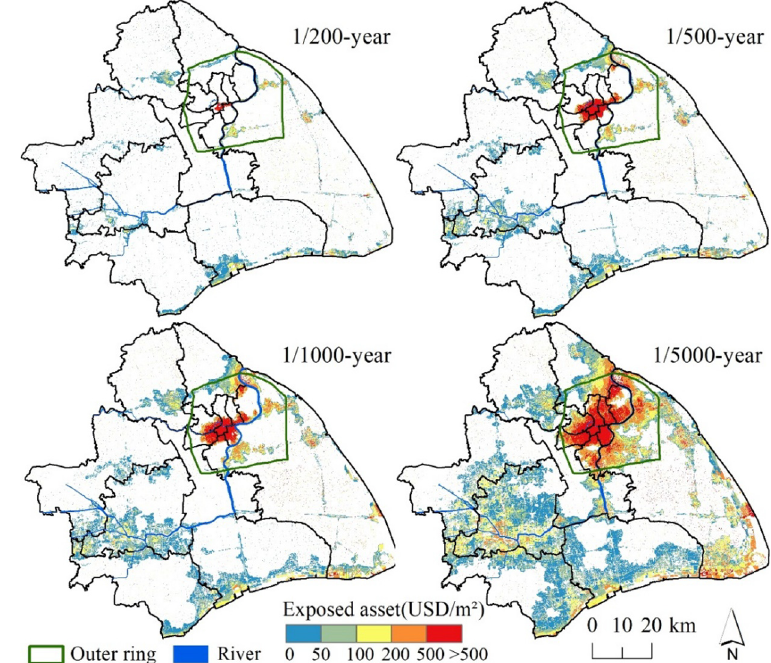
Figure 3. Spatial distribution of exposed assets under the four fl ood scenarios in Shanghai